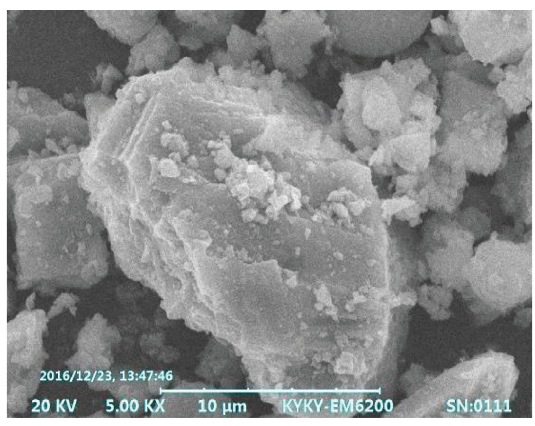
Figure 6: Steel slag (SEM).